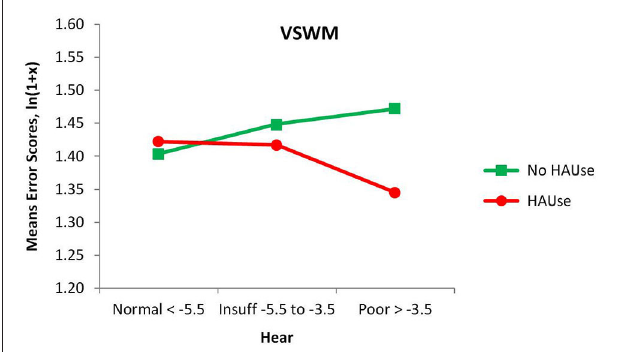
FIGURE 2 | Mean error scores (ln(1 + x )) for VSWM plotted as a function of hearing and the use of hearing aids .